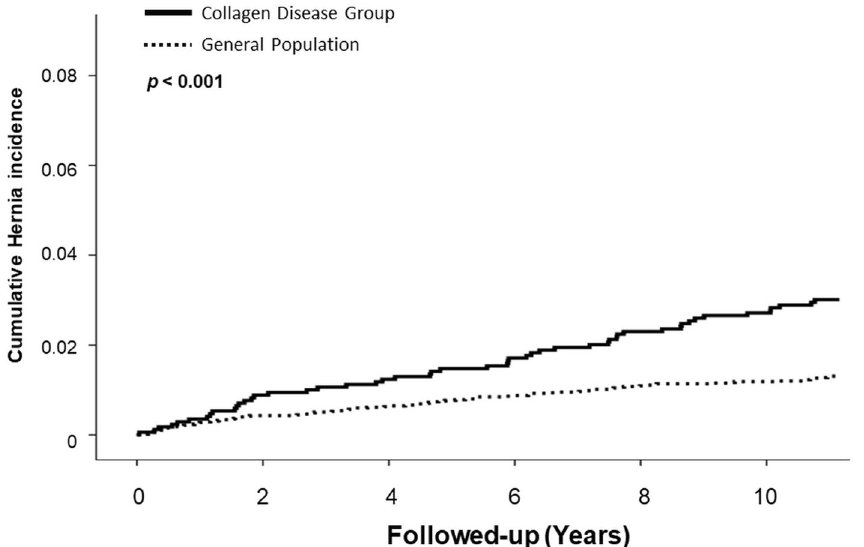
Figure 2. Cumulative incidence of hernia development. The solid line represents the collagen disease group while the dotted line represents the general